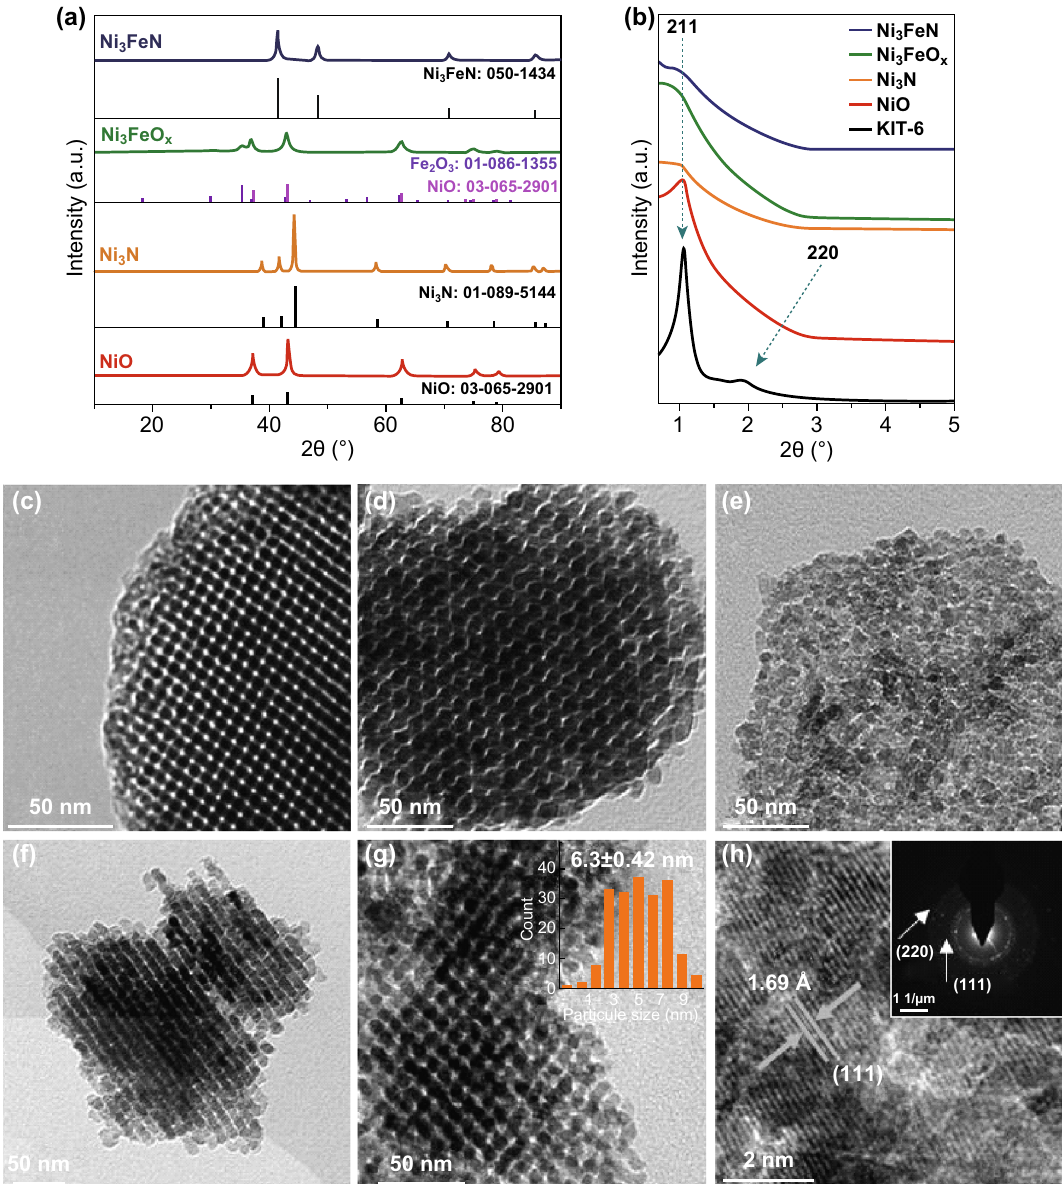
Fig. 2 a Wide-angle XRD patterns of ordered mesoporous NiO, Ni 3 N, Ni 3 FeO x mixed oxide, and Ni 3 FeN and their standard XRD JCPDS data. b Low-angle powder XRD patterns of KIT-6 and mesoporous materials replicated from KIT-6 silica. TEM images of c KIT-6 silica template along the [111] direction, d NiO, e Ni 3 FeO x , f Ni 3 N, and g Ni 3 FeN (inset: the corresponding particles sizes distributions); h HRTEM of Ni 3 FeN (inset: the corresponding